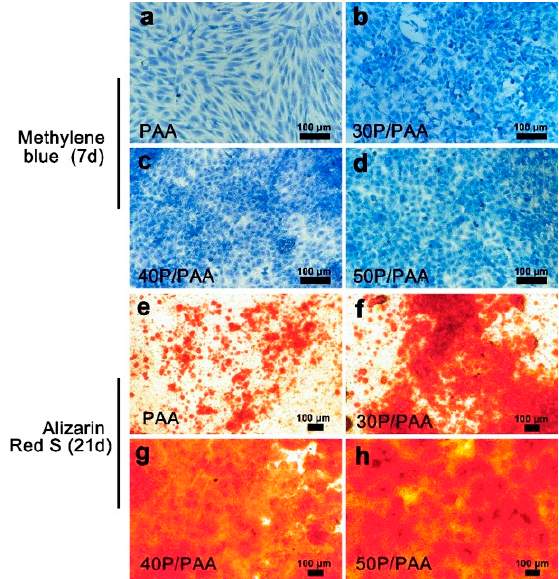
Figure 10. Methylene blue solution staining on PAA and the composites after 7 days: ( a ) PAA, ( b ) 30P/PAA, ( c ) 40P/PAA, ( d ) 50P/PAA; Alizarin red staining on PAA and the composites after 21 days: ( e ) PAA, ( f ) 30P/PAA, ( g ) 40P/PAA, ( h ) 50P/PAA. The scale bar is 100 µm.